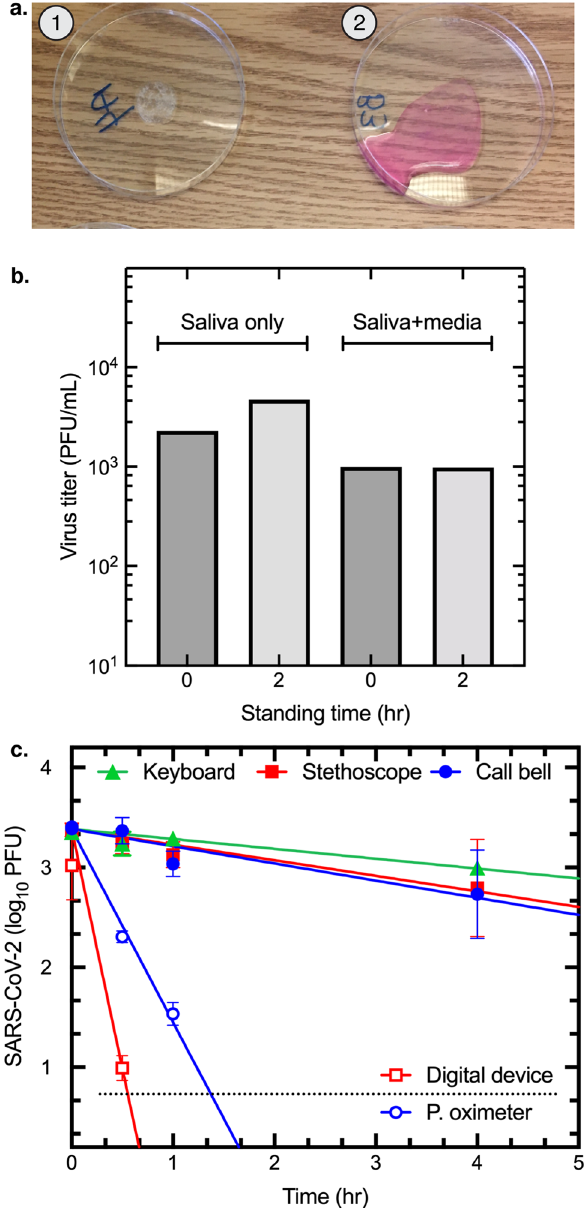
Figure 5. Stability of SARS-CoV-2. ( a ) Saliva from a COVID-19 patient, or saliva mixed with DMEM + serum, were left in open Petri dishes in a patient care room. Image showing the effects of leaving a saliva sample